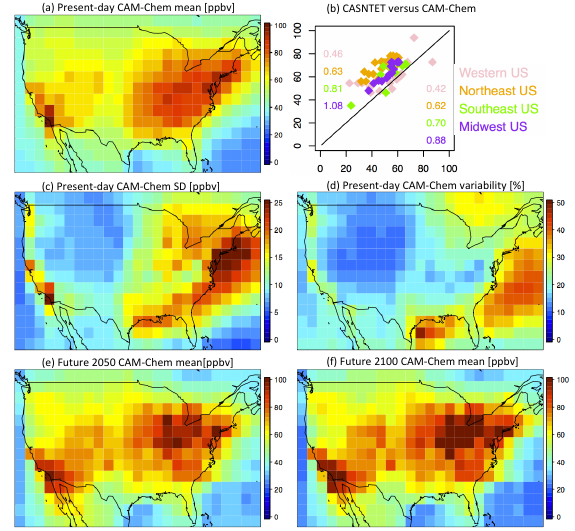
Figure 2. Continental US surface maps of (a) present-day CAM- chem mean MDA8 O 3 , (b) CAM-Chem ( y axis) comparison to CASTNET observations ( x axis) for the year 2000 (see Brown- Steiner et al., 2018, for additional comparisons), (c) present-day CAM-chem standard deviation of MDA8 O 3 , (d) present-day CAM-chem variability (standard deviation divided by mean, as a percent), (e) future CAM-chem year-2050 mean MDA8 O 3 , and (f) future CAM-chem year-2100 mean MDA8 O 3 . All model results are averaged over every JJA day in the time series, while the CAST- NET results are only for the year 2000. The numbers in (b) are slopes (left) and R 2 values